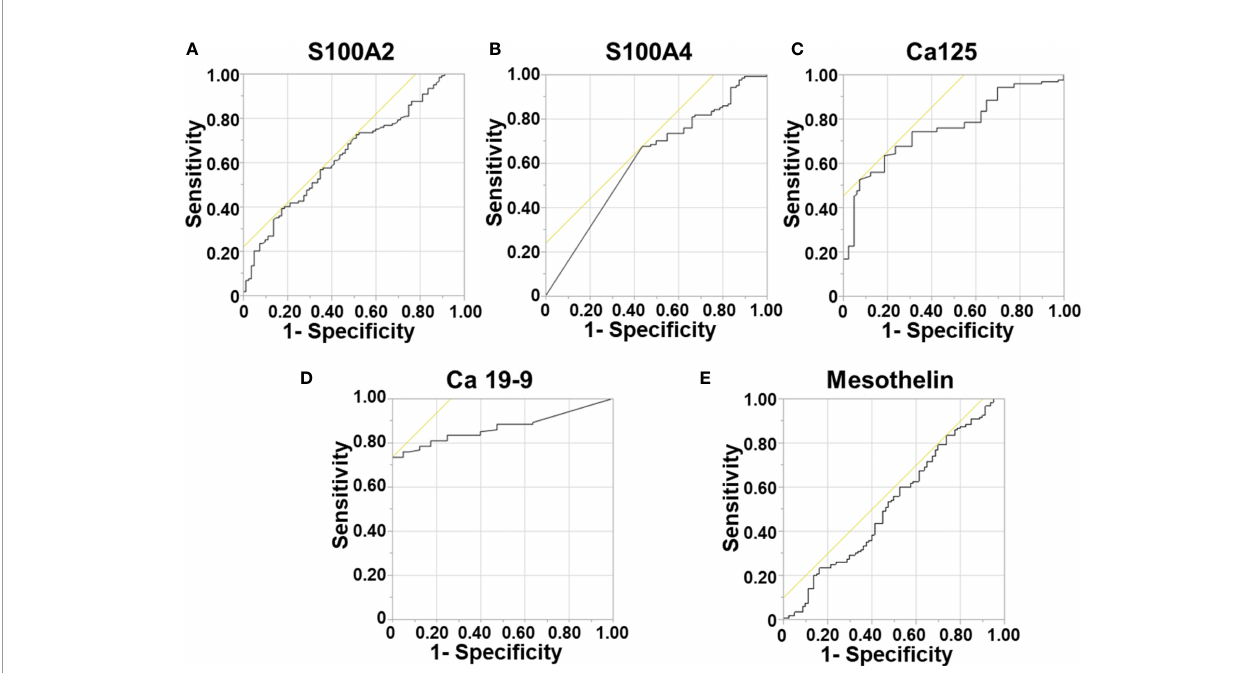
FIGURE 1 | Diagnostic Ability of Biomarkers. Receiver Operator Curves were generated to determine the diagnostic potential of individual biomarkers. for: (A) S100A2; (B) S100A4; (C) Ca-125; (D) Ca 19-9; and (E) Mesothelin.